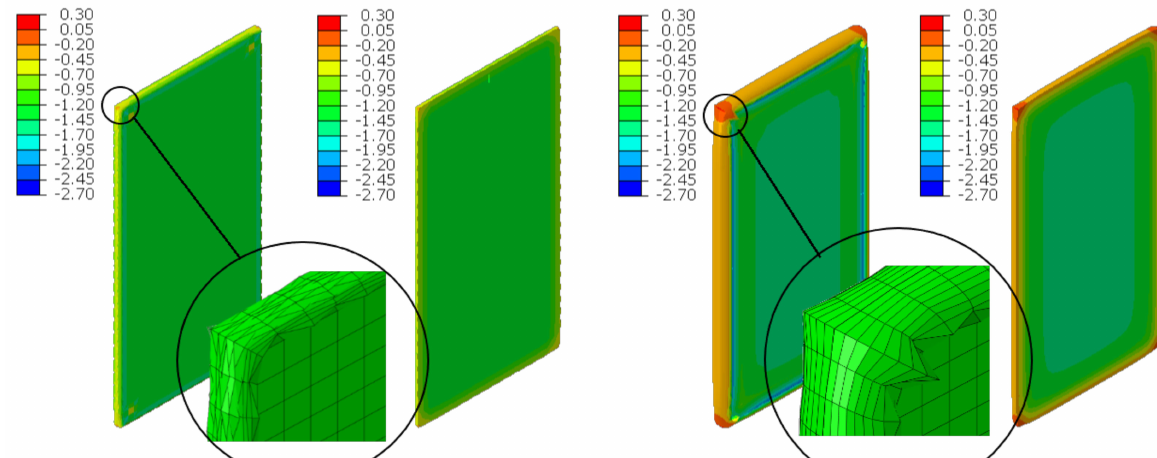
Figure 5. Deformations for scaling factor 1.0 and Cauchy stresses σ z in MPa for final load level. The width of the gap is equal to 1.0 cm, left graphic, and 2.0 cm, right graphic. Views on connection, first and third columns, or central plane, second and fourth columns. Details of deformation are enlarged.